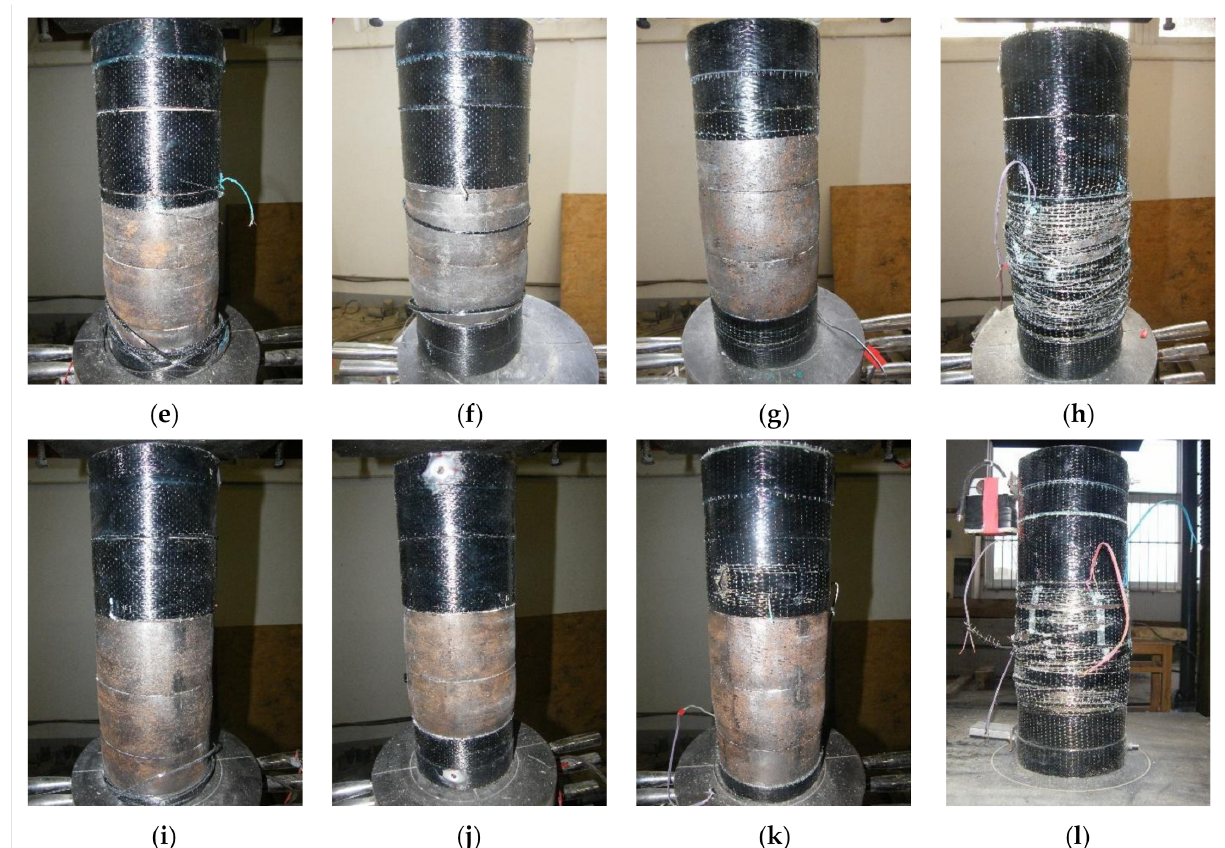
Figure 3. Failure modes of the CFGCT columns. ( a ) S4.5C1. ( b ) S4.5C3. ( c ) S4.5B2. ( d ) S4.5B3. ( e ) S6.0C2. ( f ) S6.0C3. ( g ) S6.0B1. ( h ) S6.0B3. ( i ) S7.5C1. ( j ) S7.5C2. ( k ) S7.5B1. ( l )